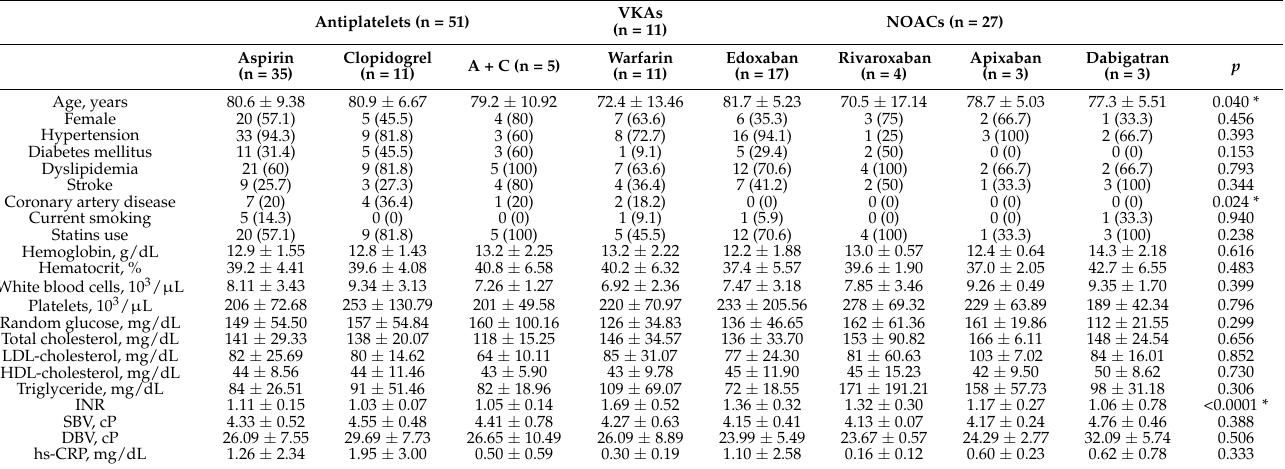
Table A2. The baseline characteristics of the study population according to the type of prior used antithrombotic